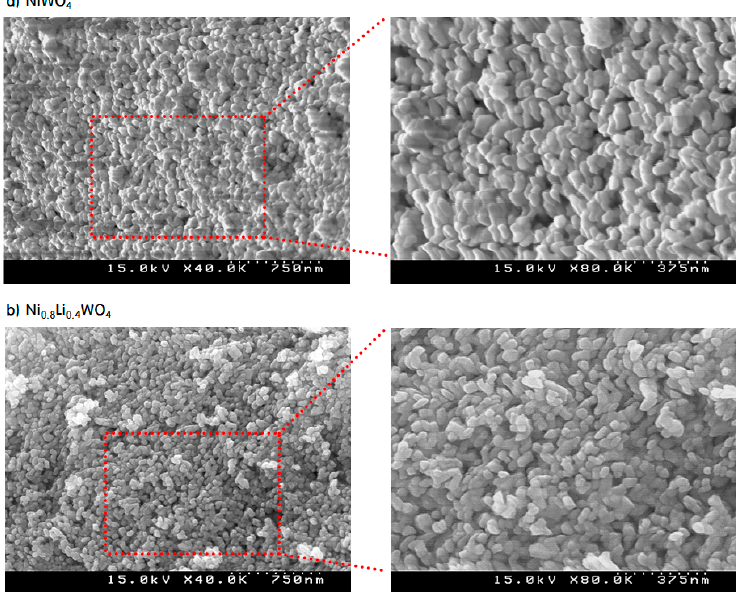
Figure 4. SEM images of NiWO 4 ( a ) and Ni 0.8 Li 0.4 WO 4 ( b ) particles.